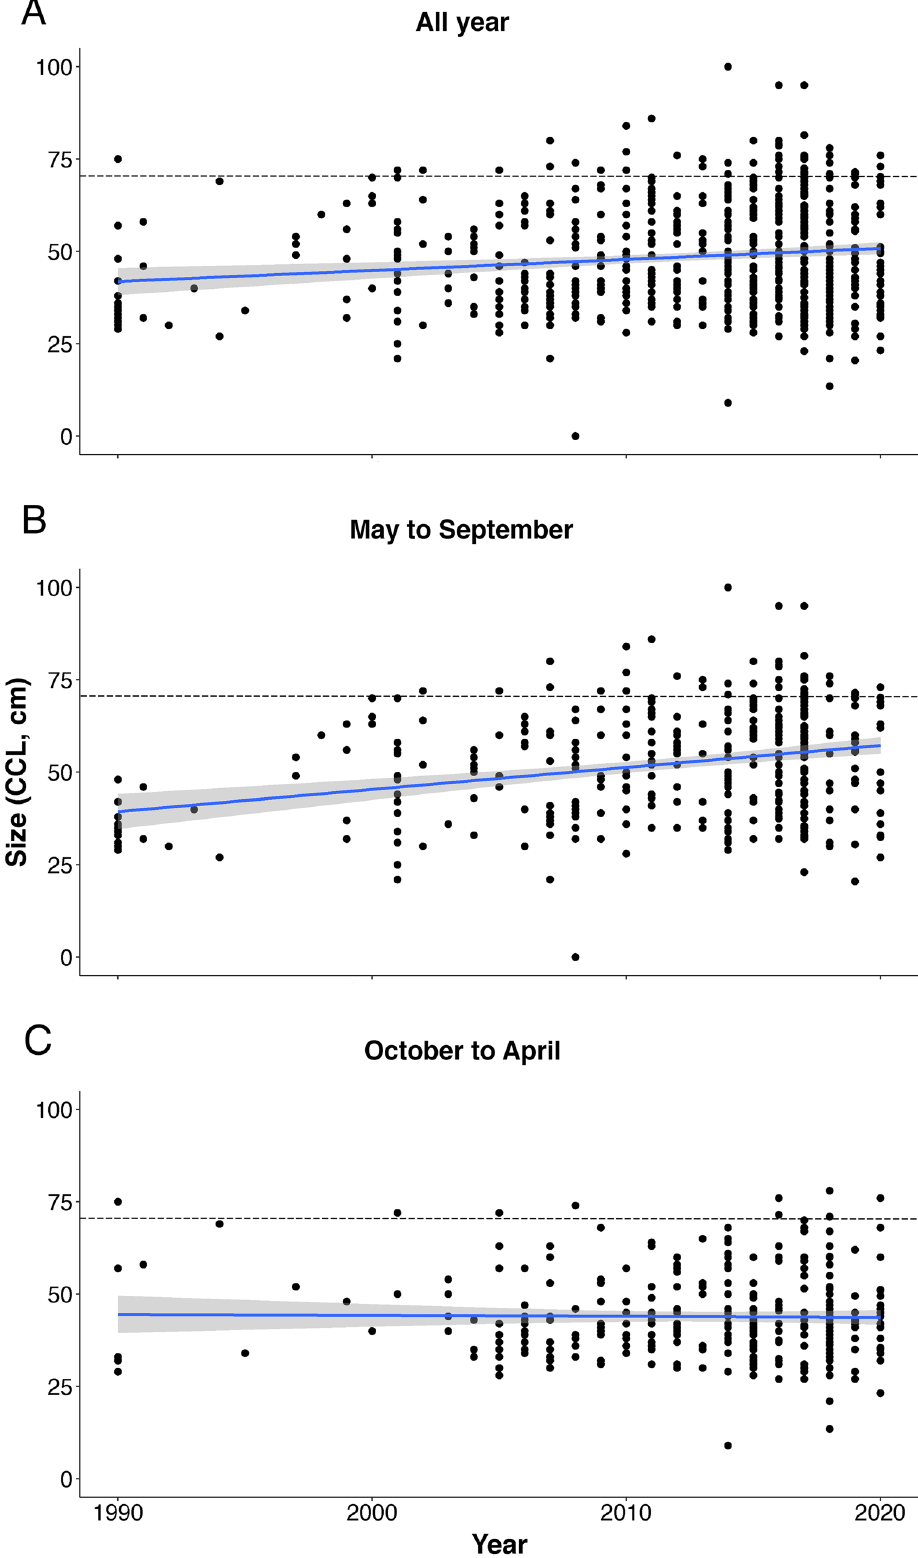
Figure 3. Changes in loggerhead turtle size (curved carapace length, CCL) between 1990 and 2020 (n = 700). Plots represent size as a function of year of observation and include ( A ) all data collected between 1990 and 2020, ( B ) data collected during the summer months (May to September) and ( C ) data collected during the winter months (October to April). For each plot, linear regression lines and associated standard errors are represented. The dashed lines indicate the 70 cm CCL threshold beyond which individuals are considered to be sexually